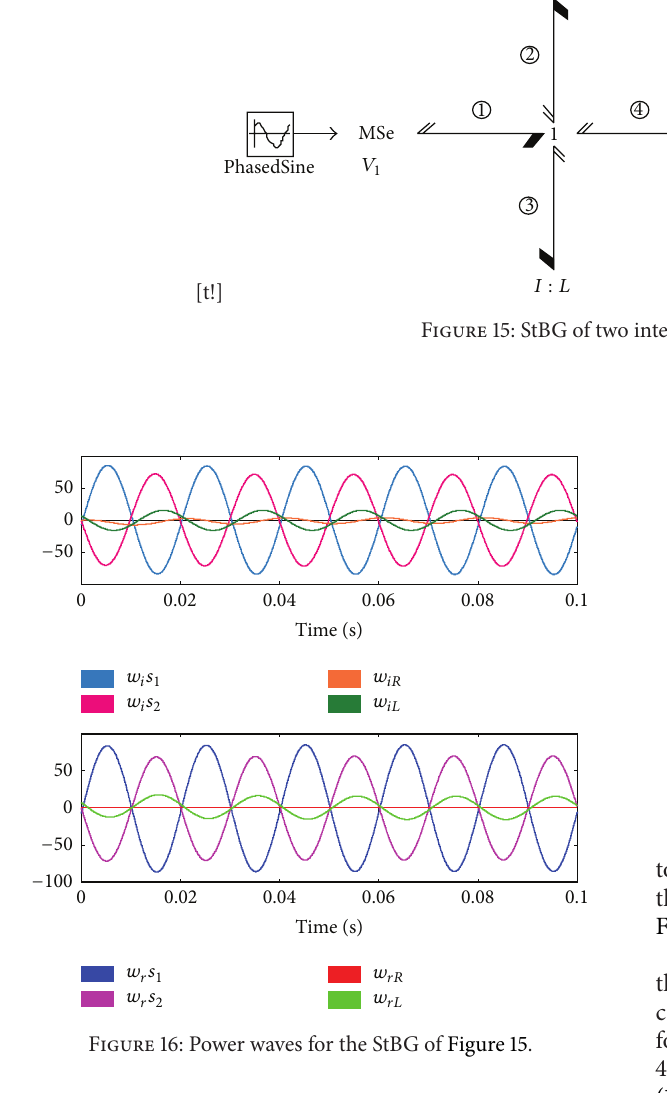
match closely the active power values calculated earlier ((10) and (11)).